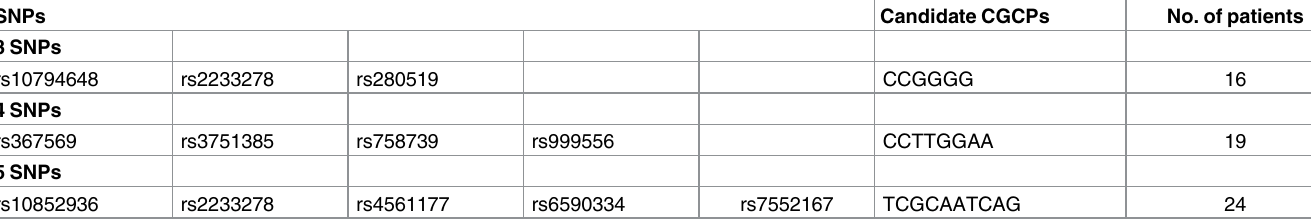
Table 2. The toppest candidate CGCP results for three, four and five SNPs and corresponding number of psoriasis patients. SNPs